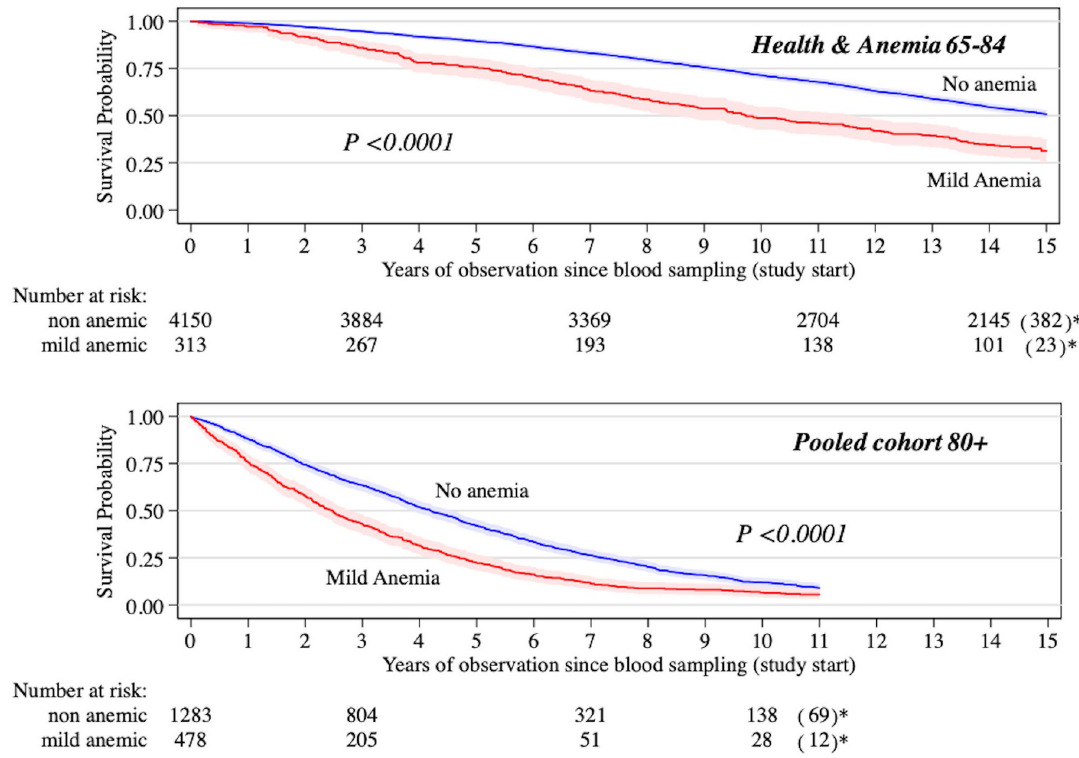
Fig 1. Survival by mild anemia status in the Health & Anemia 65–84 cohort and in the pooled Health & Anemia 85+ and Monzino 80+ cohort. Kaplan-Meier curves for individuals aged 65–84 years and 80 years or older. The shaded area indicates 95% confidence intervals. Mild anemia was defined as hemoglobin concentration between 10.0 and 11.9 g/dl in women and between 10.0 and 12.9 g/dl in men [23–25]. � Individuals included in the studies